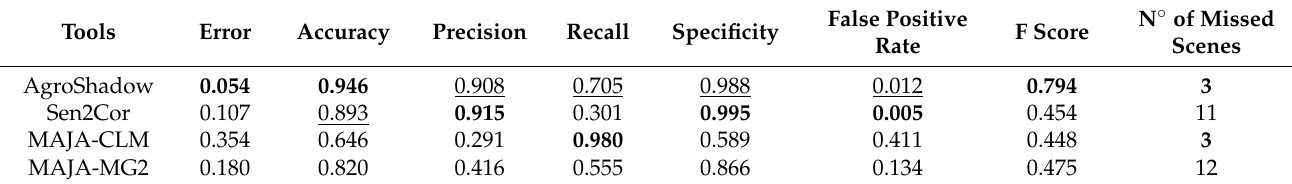
Table 3. Comparison between classification metrics of AgroShadow, Sen2Cor and MAJA shadow classes for all the scenes (bold numbers indicate the best metrics, underlined numbers are values quite near to the best metrics). CLM = clouds/cloud shadows classification mask; MG2 = geophysical